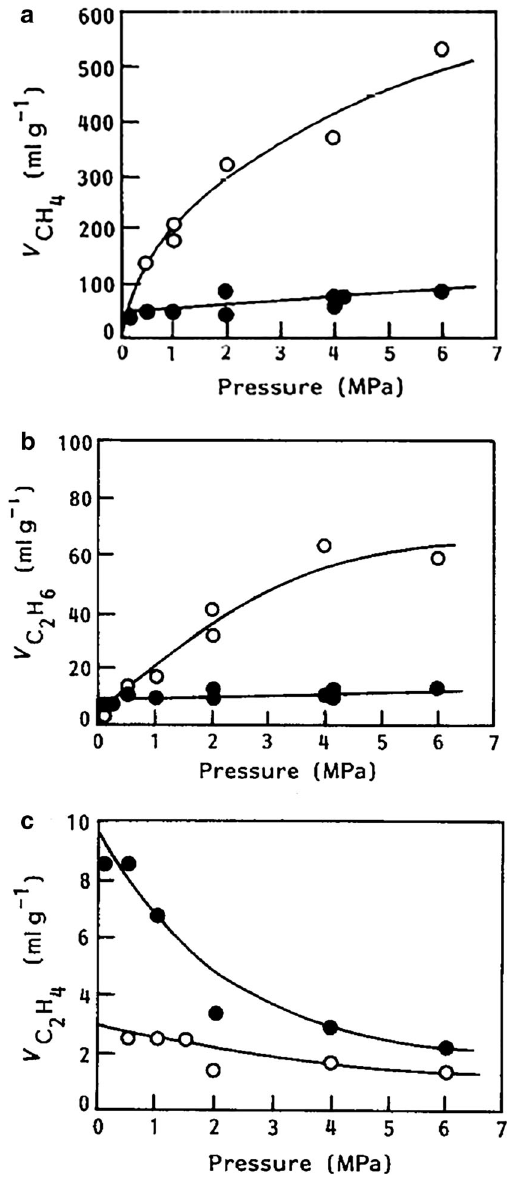
Fig. 6 Effects of pressure on: a CH 4 yield at 800 (cid:3) C, b C 2 H 6 yield at 800 (cid:3) C, c C 2 H 4 yield at 800 (cid:3) C (Symbol: Open circle for H 2 atmosphere and Filled circle for N 2 atmosphere); Sha et al. (1990)